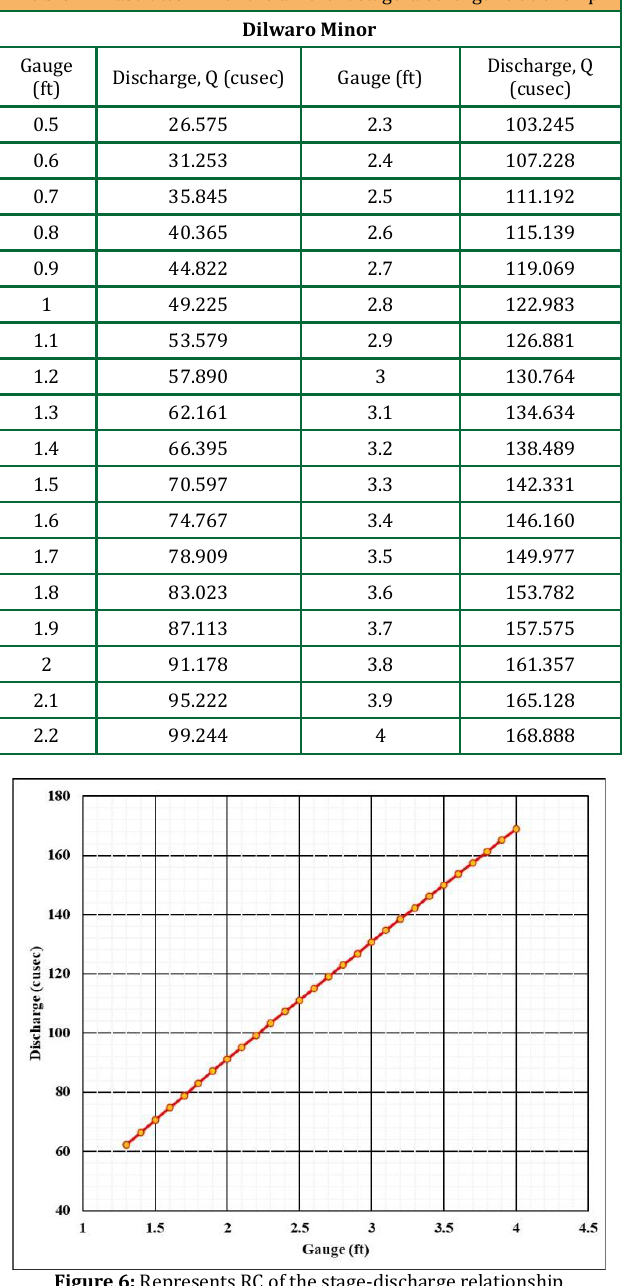
Figure 6: Represents RC of the stage-discharge